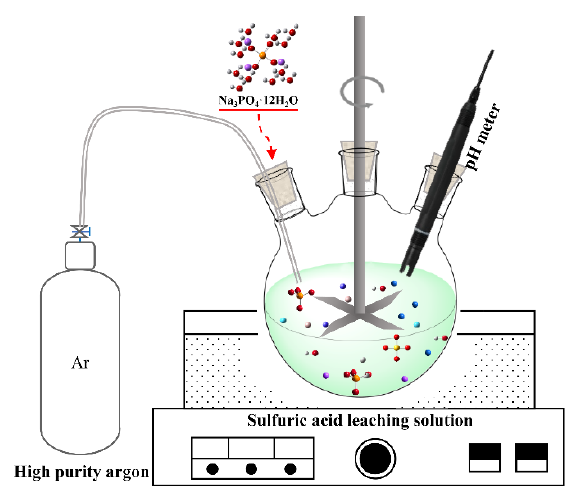
Figure 1. Schematic plot of the precipitation experiments set-up. The removal rate of Al 3+ and F − as well as the loss rate of Fe during the purification process were computed by Equation (1).